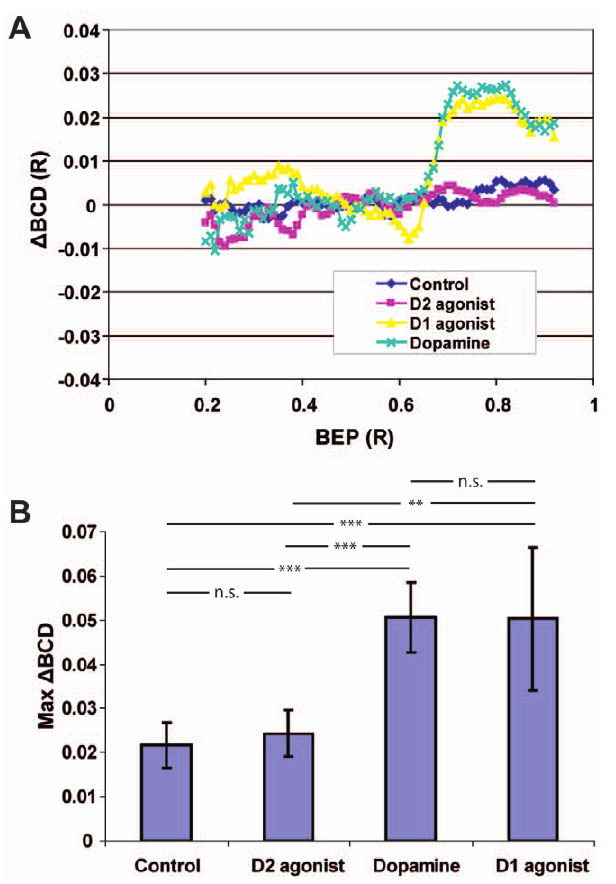
Figure 3. The effectofdopamine is abolished by a D1-antagonist. (A) D BCD curves from 11 lens pairs where one lens was treated with dopamine and the other lens remained untreated are compared with D BCDcurves from10lens pairswhere one lens was treatedwithdopamine and the other lens with dopamine and the D1-antagonist SCH 23390. The curves are similar, indicating that the D1-antagonist abolished the effect of dopamine in the lens. The curves represent the mean D BCDs from 21 animals (Control: n=11, D1 antagonist: n=10). (B) The max- D BCDs and standard deviation. Both groups were similar with no statistically significant difference between them. This indicates that the D1-antagonist abolished the effect of dopamine. There was no significant (n.s) difference between the two groups (n=21).